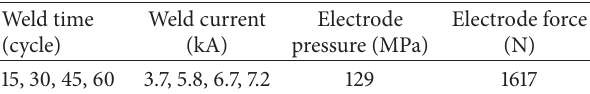
Table 1: Chemical composition of steel %.